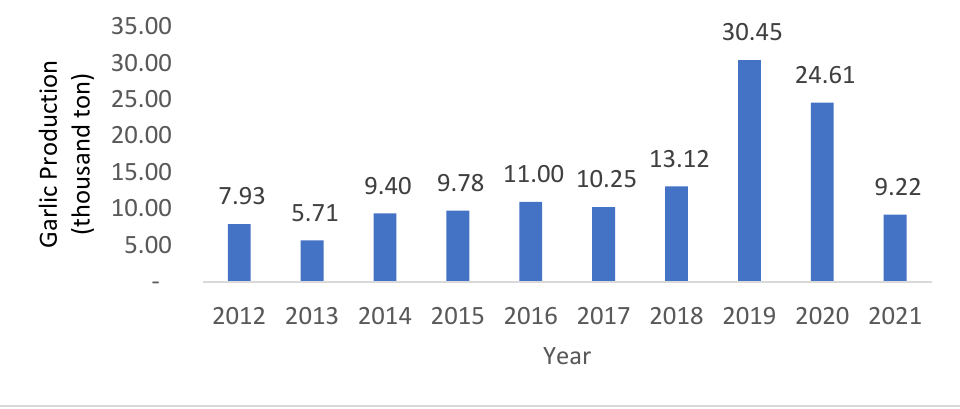
Figure 1. Garlic production (thousand tons) in West Nusa Tenggara, Indonesia, in 2012–2021 [4].